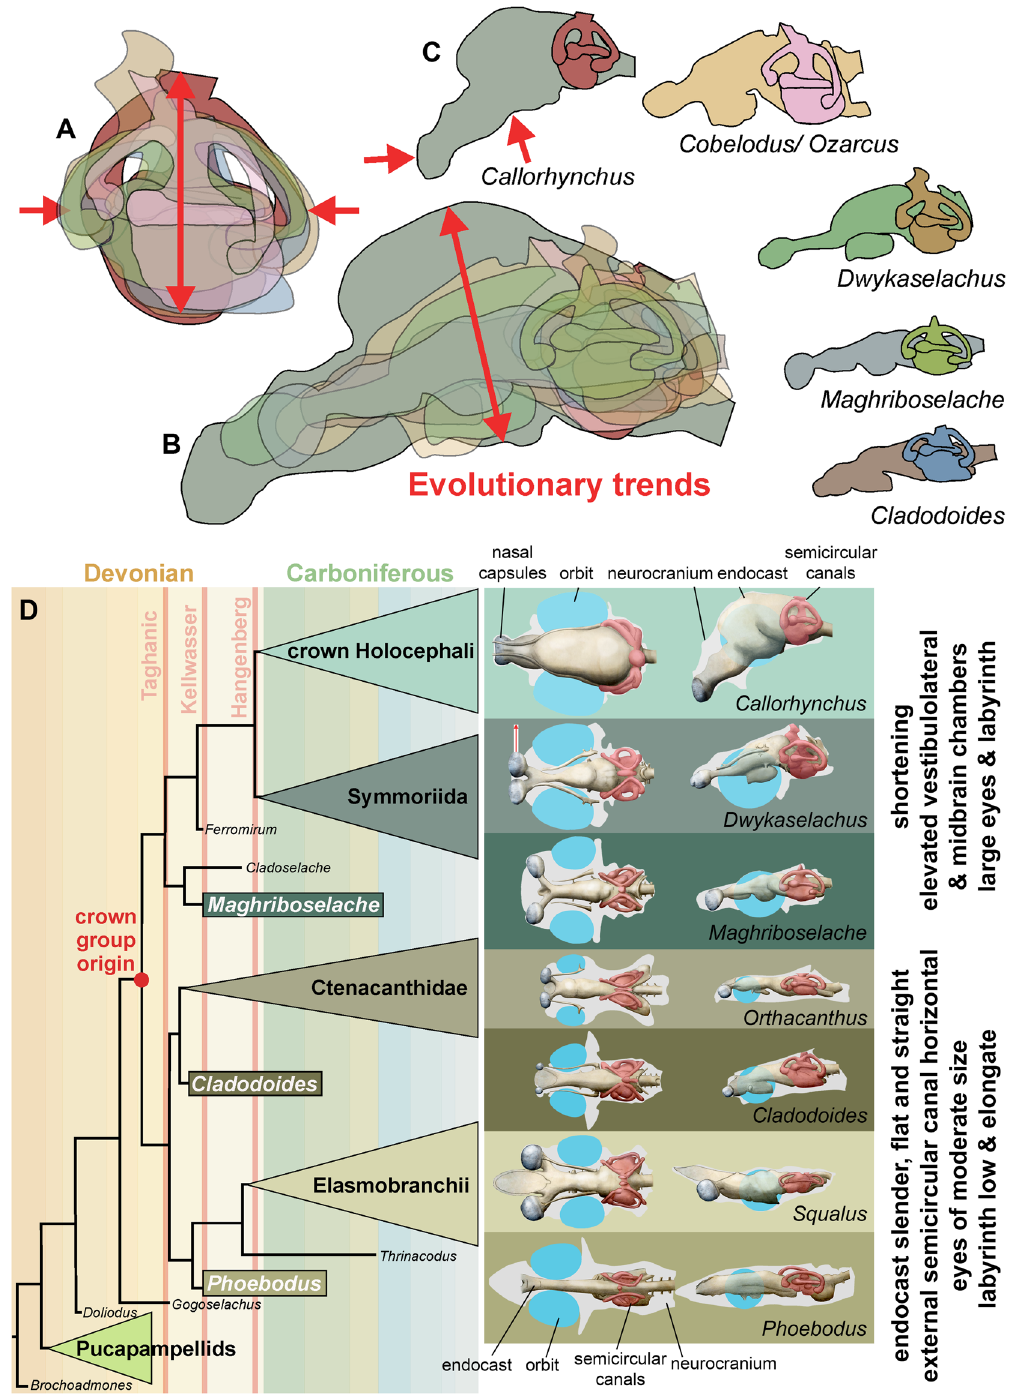
Fig. 14 Endocasts of various extinct and extant chondrichthyans of the main chondrichthyan clades and evolutionary change in the holocephalan branch. A Overlain labyrinths of the genera in F (note the increase in height and decreasing length). B Overlain endocasts of the genera in C (note the increasing volume of the mesencephalon and the dorsal bulging). C Outlines of endocasts of some chondrichthyans. D Evolution of neurocrania, sensory organs, brain endocasts and labyrinths exemplified with seven genera. Eyes reconstructed in blue, labyrinth in red, neurocranium outline in grey. Most endocasts after Coates et al. (2017), Phoebodus after Frey et al. (2019), and unpublished data, Maghriboselache after this